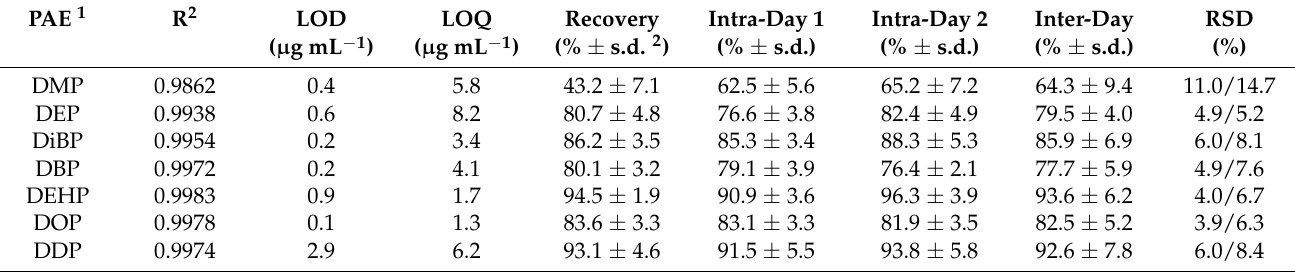
Table 2. Correlation coefficients (R 2 ) in the range 5–500 µ g mL − 1 , limit of detection (LOD), limit of quantification (LOQ), recoveries and intra-day and inter-day precision along with relative standard deviation (RSD) in coffee samples of each PAE investigated by means of SPE